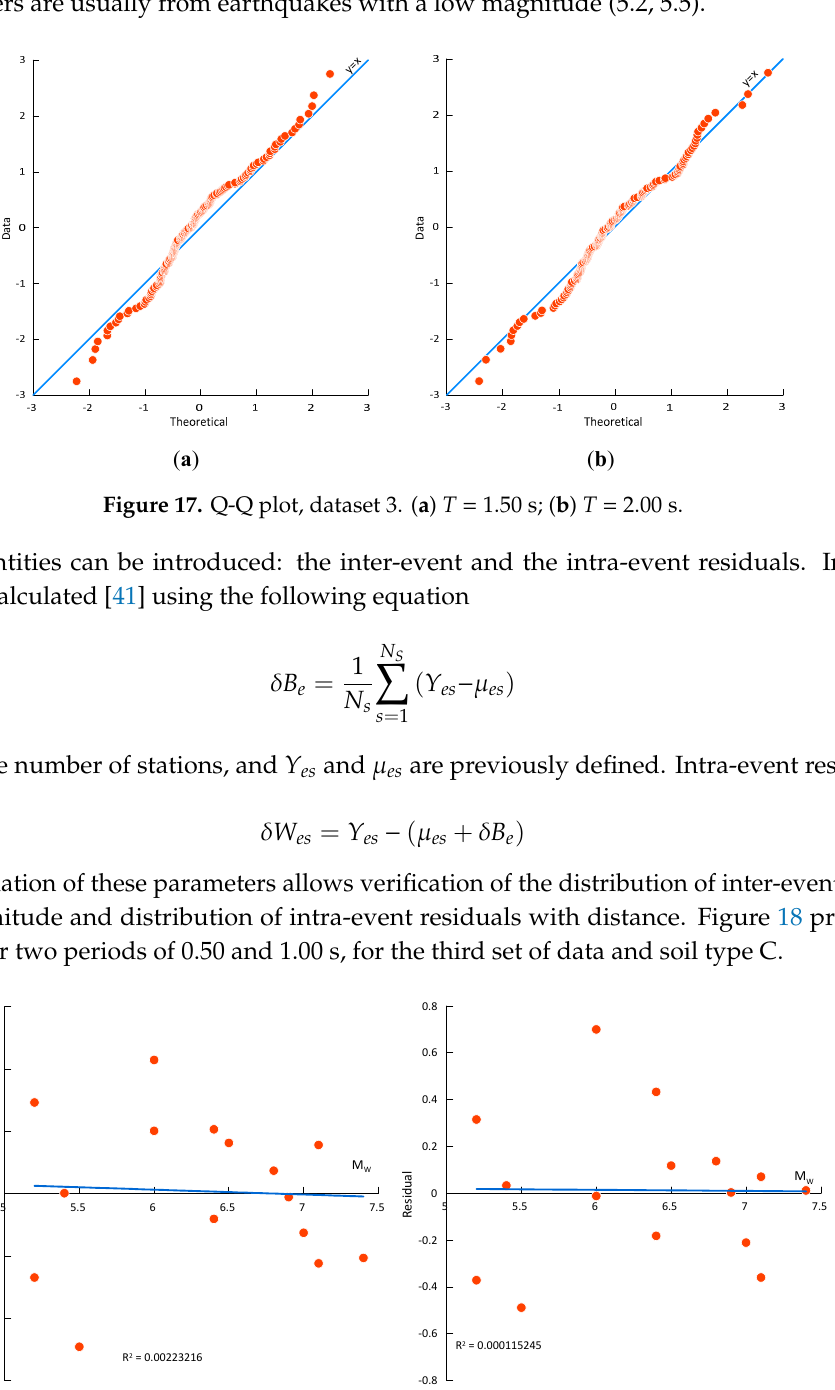
Figure 16. Q-Q plot, dataset 3. ( a ) T = 0.50 s; ( b ) T = 1.00 s.